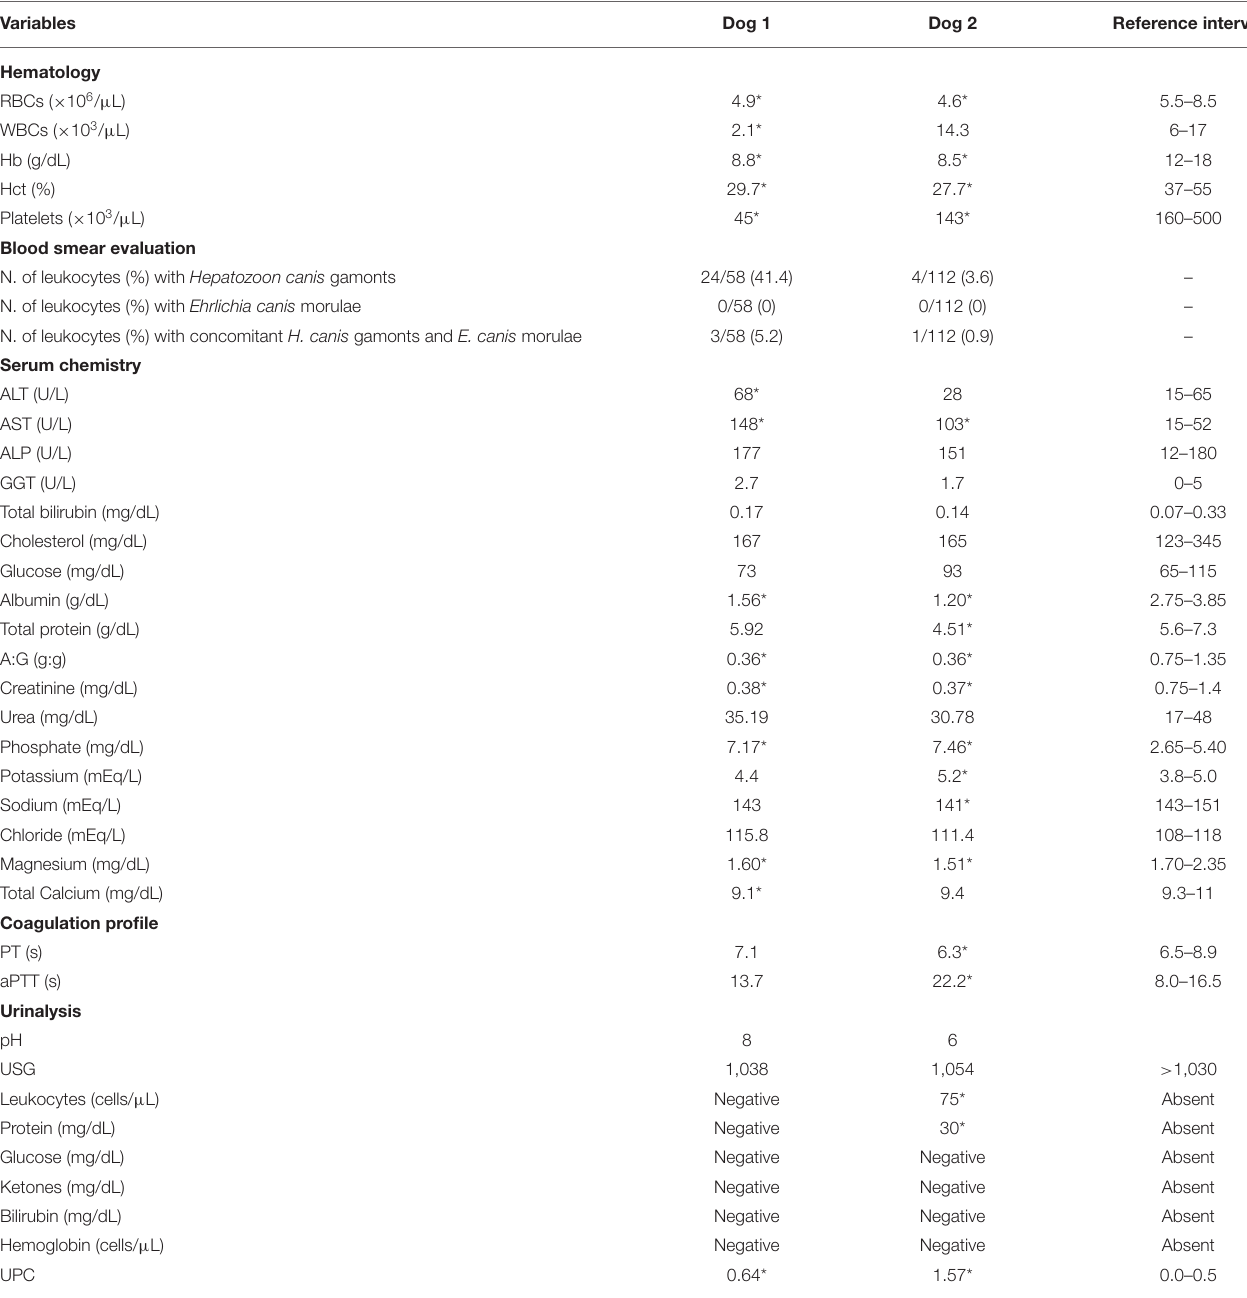
TABLE 2 | Clinicopathological results of Dog 1 and Dog